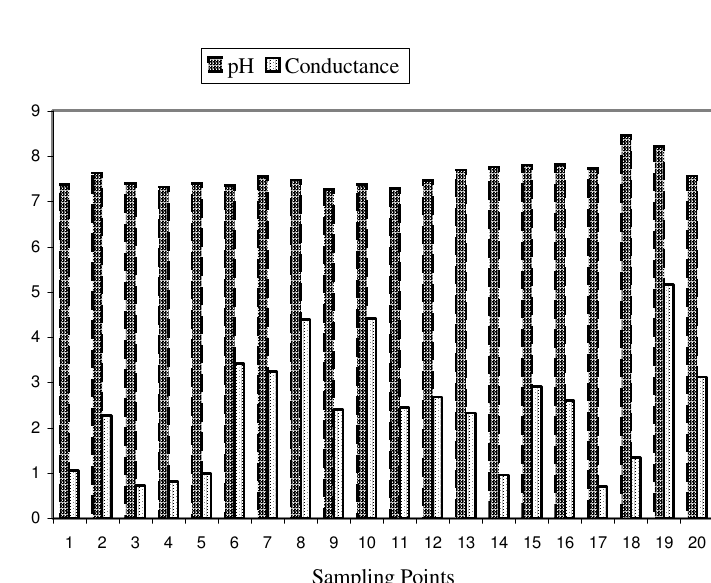
Figure 1. pH and conductance of various groundwater samples collected from Delhi.